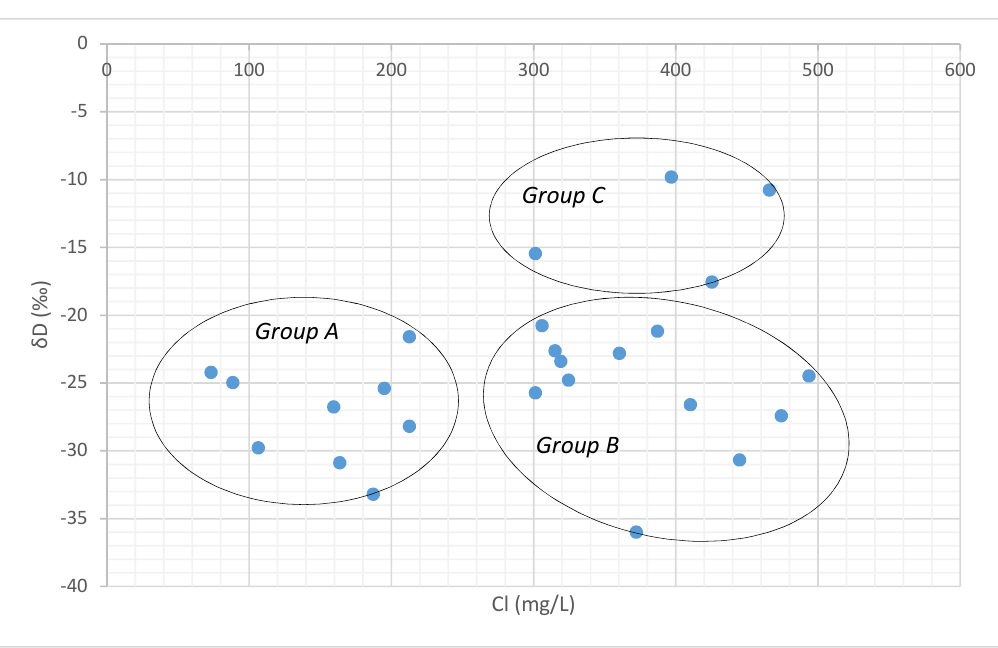
Figure 12. Chloride vs. δD plot.